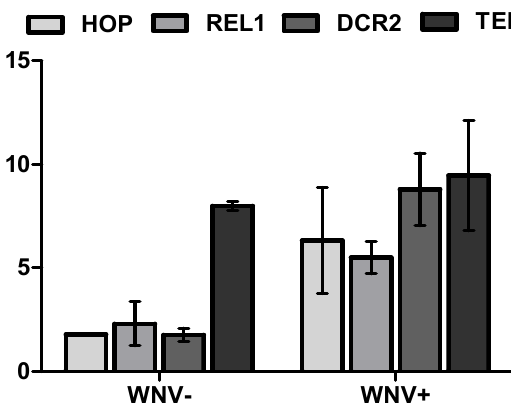
Figure 4. Cx. pipiens immune gene transcript levels at seven days post blood feeding for WNV+ and WNV − mosquitoes. Differences are expressed as mean fold change in qPCR CT (cycle threshold) +/ − SD relative to unexposed mosquitoes and normalized by rpl8 transcript levels ( ΔΔ CT). Statistically significant differences ( t -test, p < 0.001) were measured for all transcript levels for WNV exposed ( − or +) relative to unexposed mosquitoes and WNV − relative to WNV+ mosquitoes, with the exception of TEP1, for which WNV − and WNV+ groups were statistically equivalent ( p = 0.099).